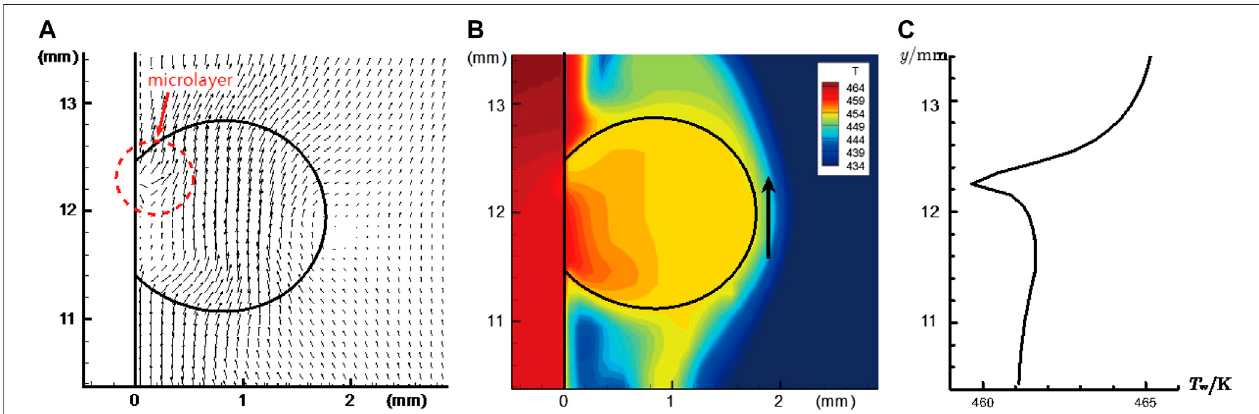
FIGURE 5 | A bubble sliding on the heating wall: (A) local velocity vector; (B) local temperature fi eld; (C) local wall temperature.